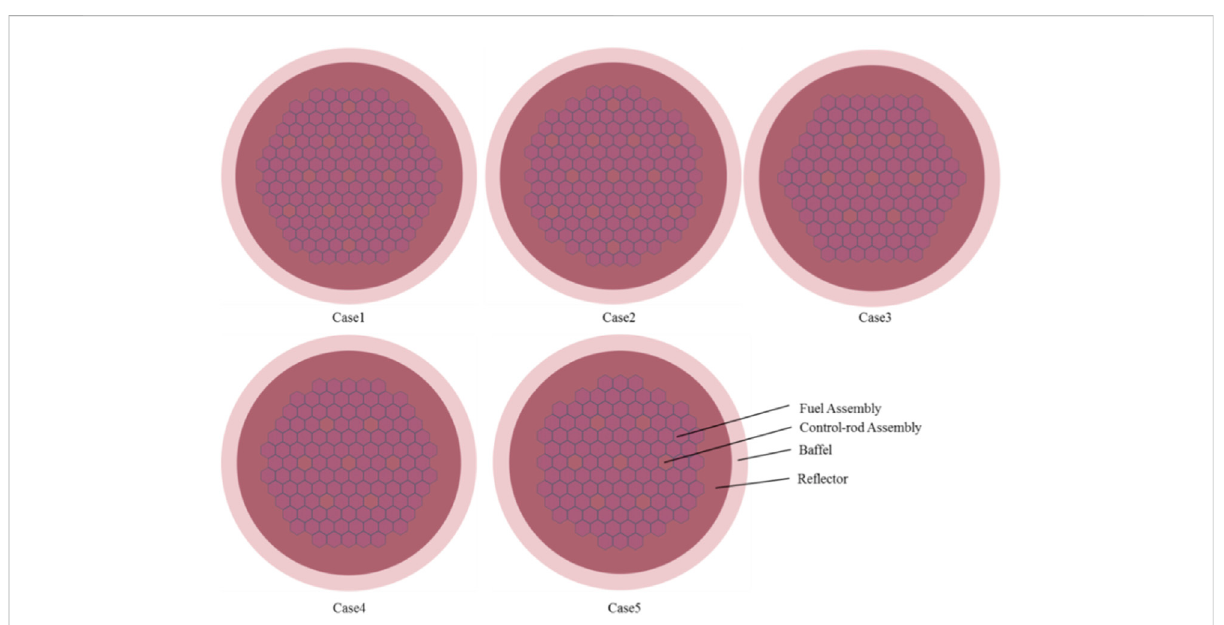
FIGURE 3 Radial core con fi guration in the height-to-diameter ratio analysis.